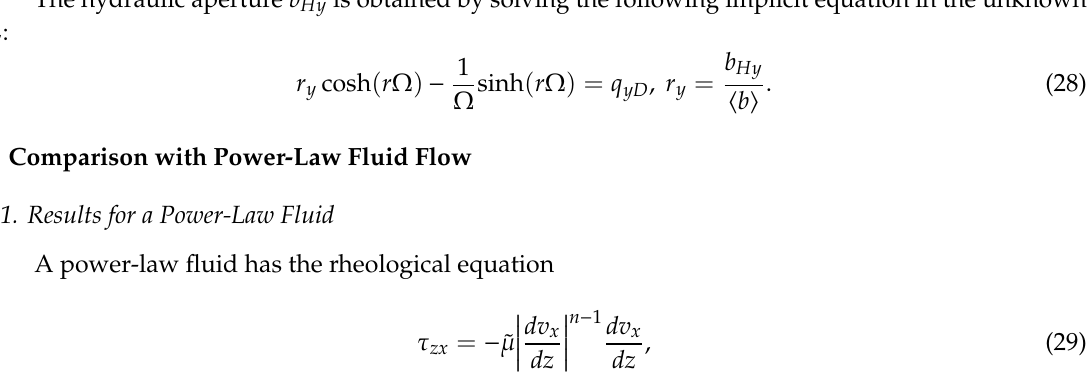
parameter d shape parameter 𝑑 .